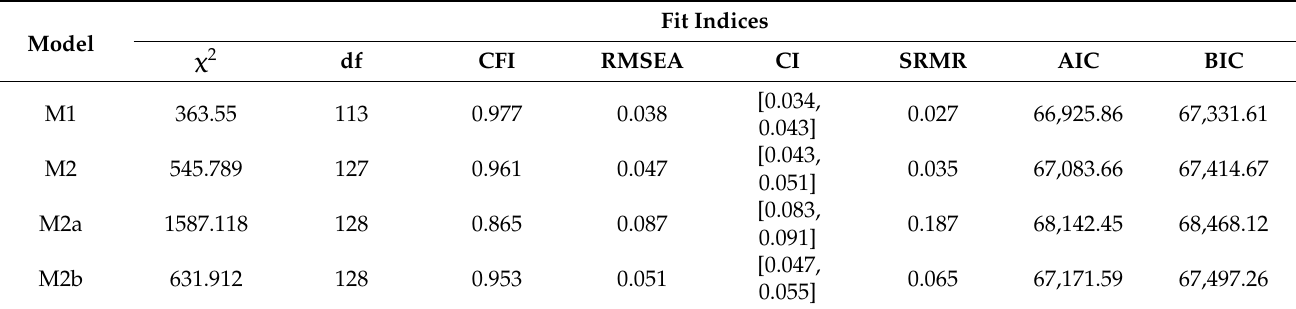
Table 1. Maximum likelihood estimation and model fit